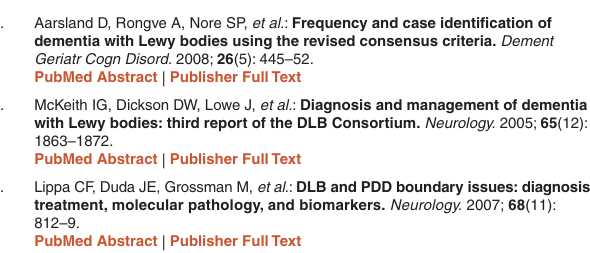
figshare : Data for synaptic proteins expression levels and patholog- ical scores in prefrontal cortex, anterior cingulate gyrus and parietal cortex, http://dx.doi.org/10.6084/m9.figshare.987087